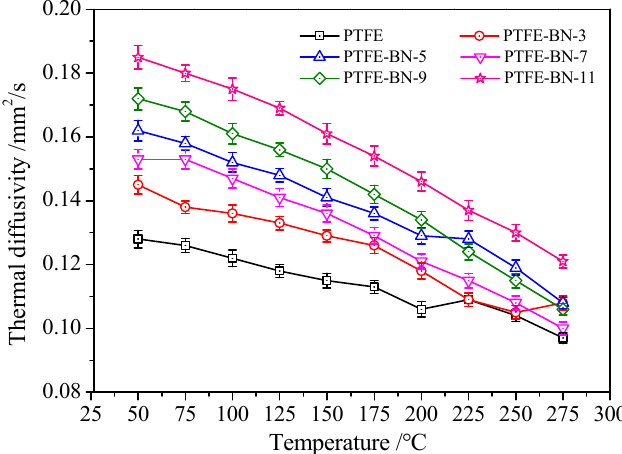
Figure 4. Thermal diffusivity of PTFE and PTFE/BN specimens.